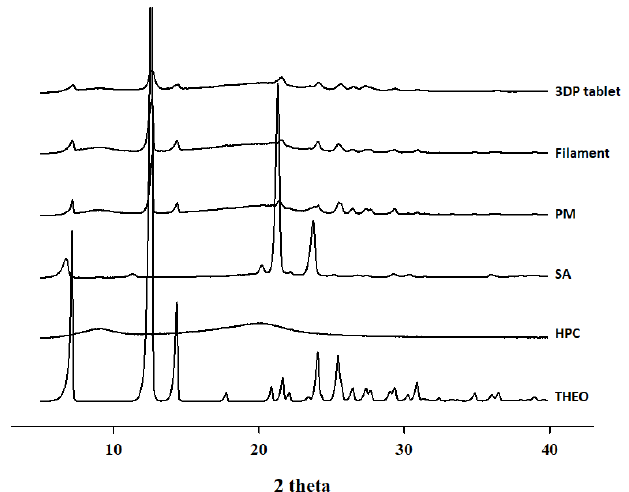
Figure 4. PXRD curves of 3DP tablet, THEO-HPC filament, PM, SA, HPC, and free